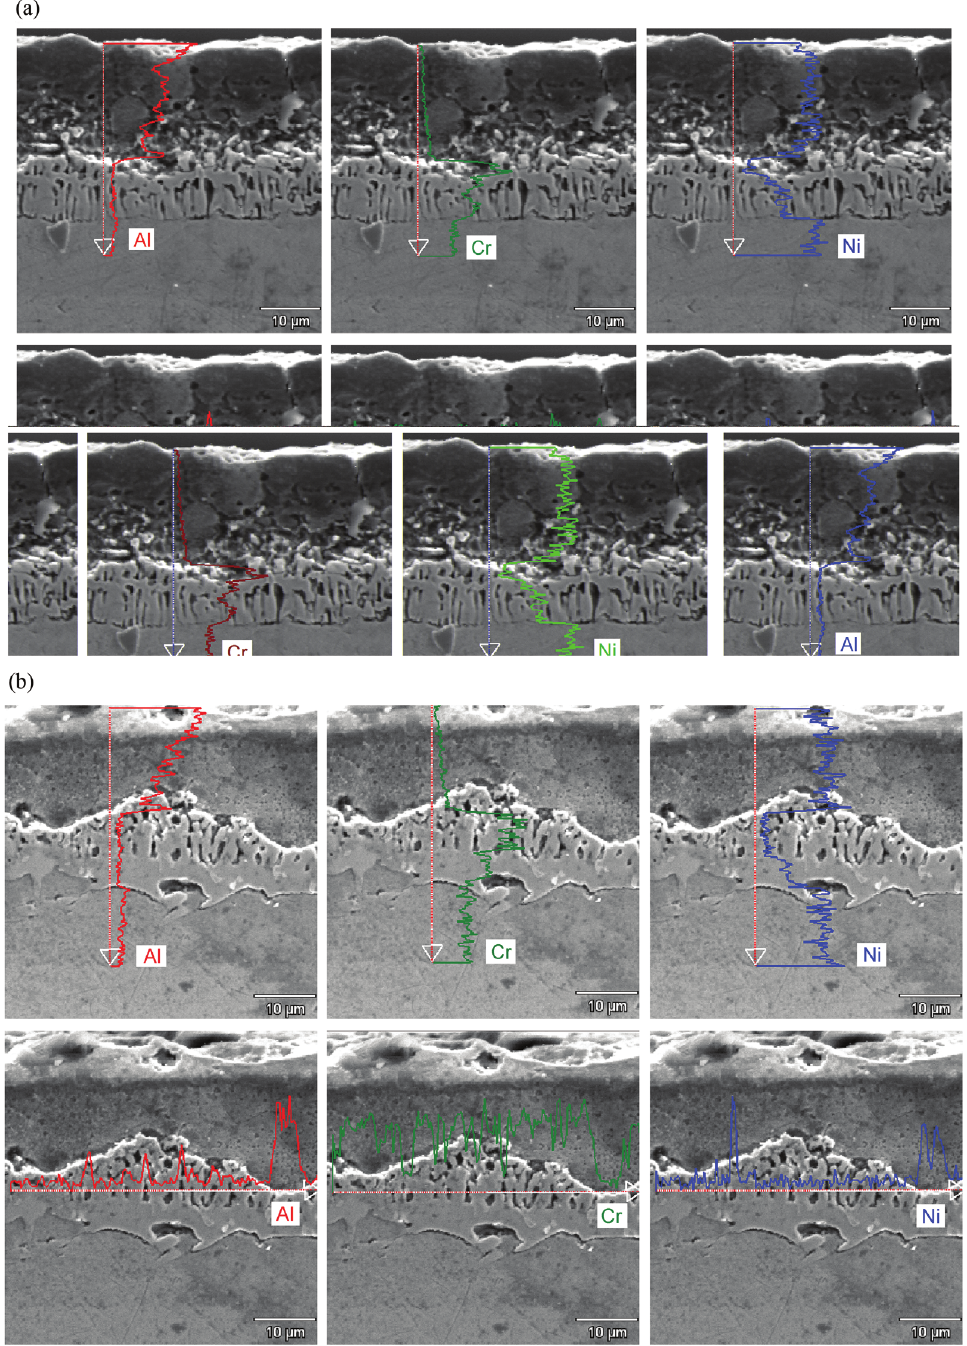
Figure 6: The analysis of the chemical composition on the aluminide coating cross section made in the CVD process: (a) T ¼ 1,020 °C, t ¼ 4 h, p